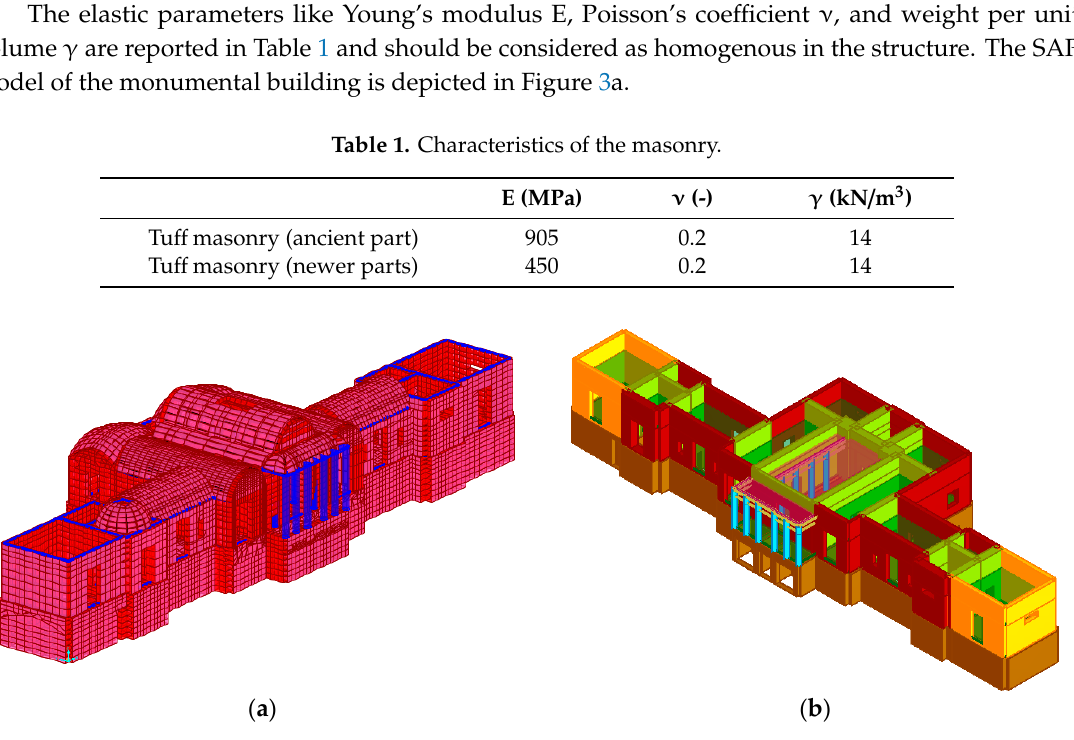
Figure 3. ( a )The SAP2000 and ( b ) TREMURI model of the case study building.